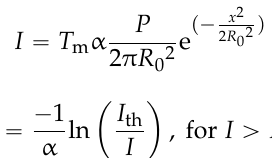
Figure 2. Transmittance spectra of the masks with T m = 20%, 40%, 60%, 80%, and 100%.